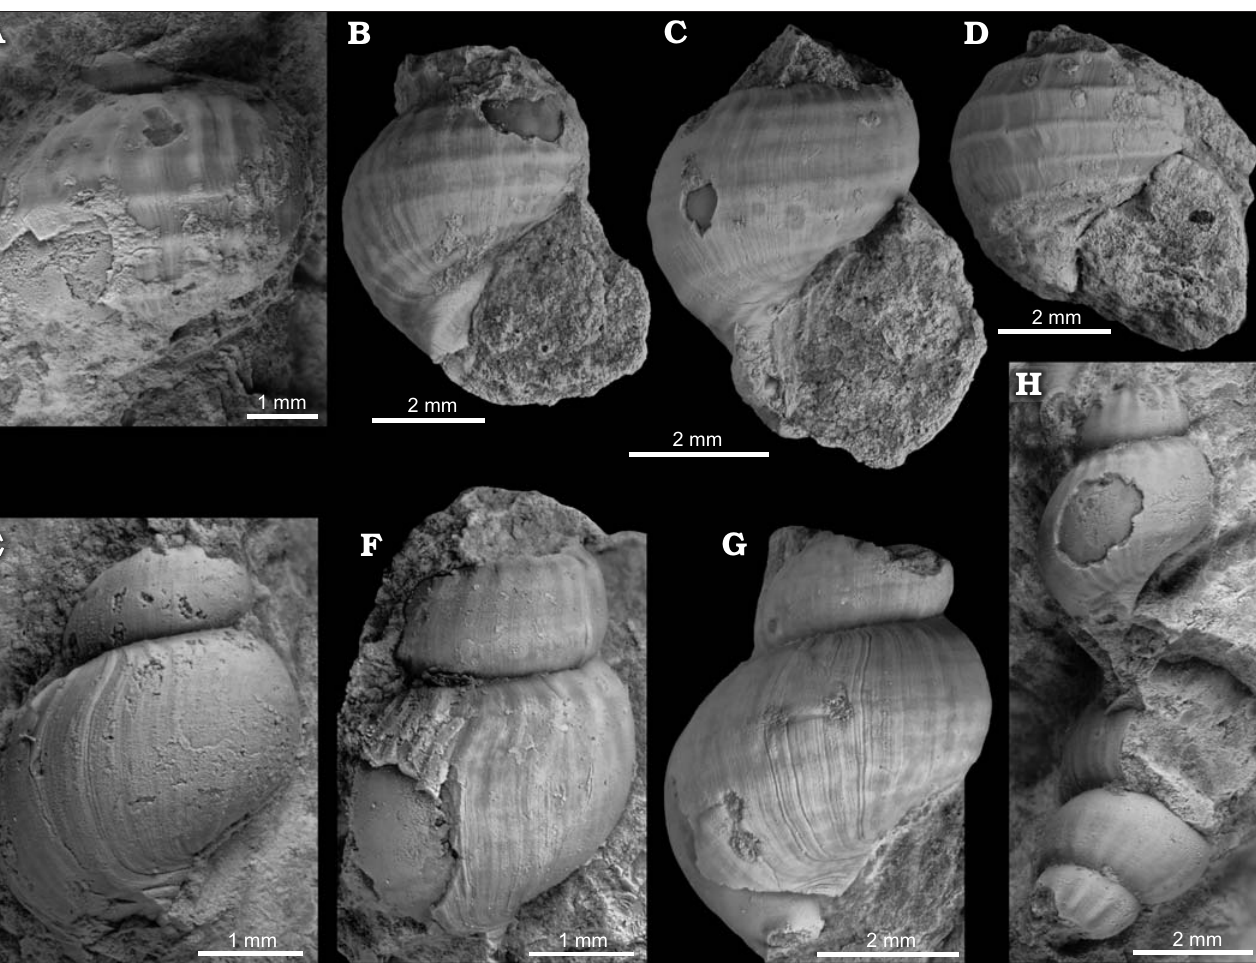
Fig. 14. The provannid gastropod Provanna antiqua Squires, 1995, from early Oligocene seep deposits at Cerro La Salina (block 1, A, F; block 4, H; block 6, B, C, D, G; block 8, E), Talara Basin, northern Peru. A . NRM Mo187044, specimen with distinctive axial and spiral sculpture, in abapertural view. B . NRM Mo187045, specimen with distinctive sculpture and showing the basal groove, in apertural view. C . NRM Mo187046, specimen with weak axial sculpture in the upper whorl, in apertural view. D . NRM Mo187047, fragmentary specimen with mainly spiral sculpture, in apertural view. E . NRM Mo187048, nearly smooth specimen showing slightly sinuous growth lines, in apertural view. F . NRM Mo187049, specimen with small shoulder and sculpture mainly in upper part of whorls, in apertural view. G . NRM Mo187050, specimen with faint axial and spiral sculpture, in apertural view. H . NRM Mo187051, two specimens with small shoulder and sculpture mainly in upper part of